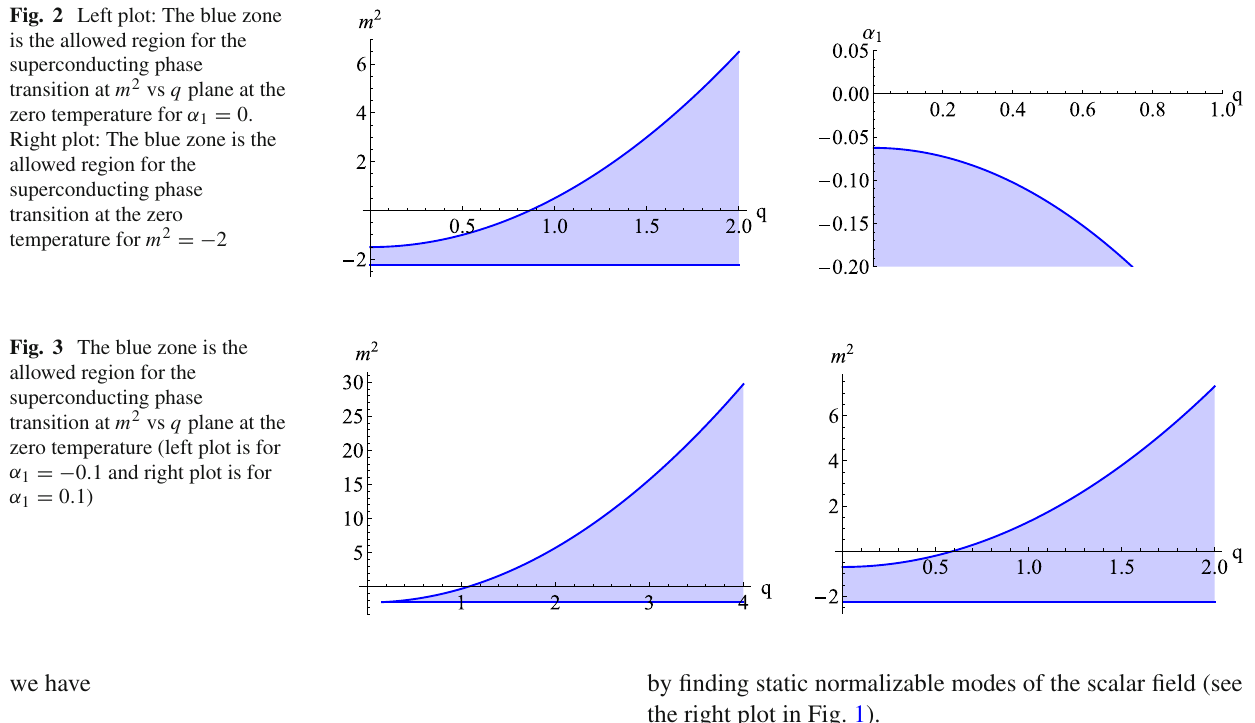
Fig. 3 The blue zone is the allowed region for the superconducting phase transition at m 2 vs q plane at the zero temperature (left plot is for α = − 0 . 1 and right plot is for 1 α = 0 . 1